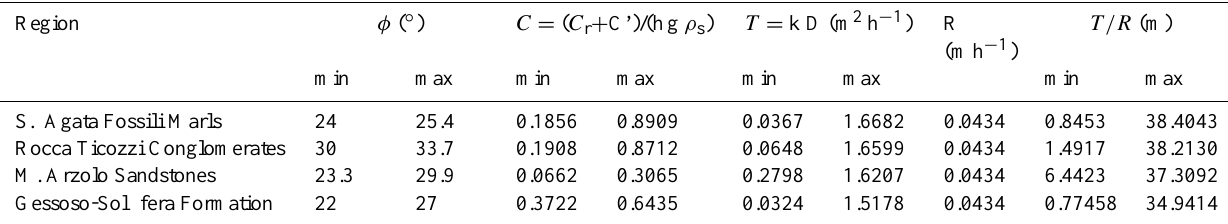
Fig. 10. Cumulative potential global solar radiation in April 2009 (values are expressed in kilowatts per square meter) and safety factor map computed by TRIGRS. Table 2. Initial values of the input parameters for SINMAP. C r is the root cohesion [Nm − 2 ], C 0 is the soil cohesion [Nm − 2 ], θ is the slope angle, ρ s is the wet soil density [kgm − 3 ], ρ w is the density of water [kgm − 3 ], g is the gravitational acceleration (9.81 ms − 2 ), D is the vertical soil depth [m], φ is the internal friction angle of the soil, h [m] is the soil thickness, T is the soil transmissivity [m 2 h − 1 ], and R is the steady-state recharge [mh − 1